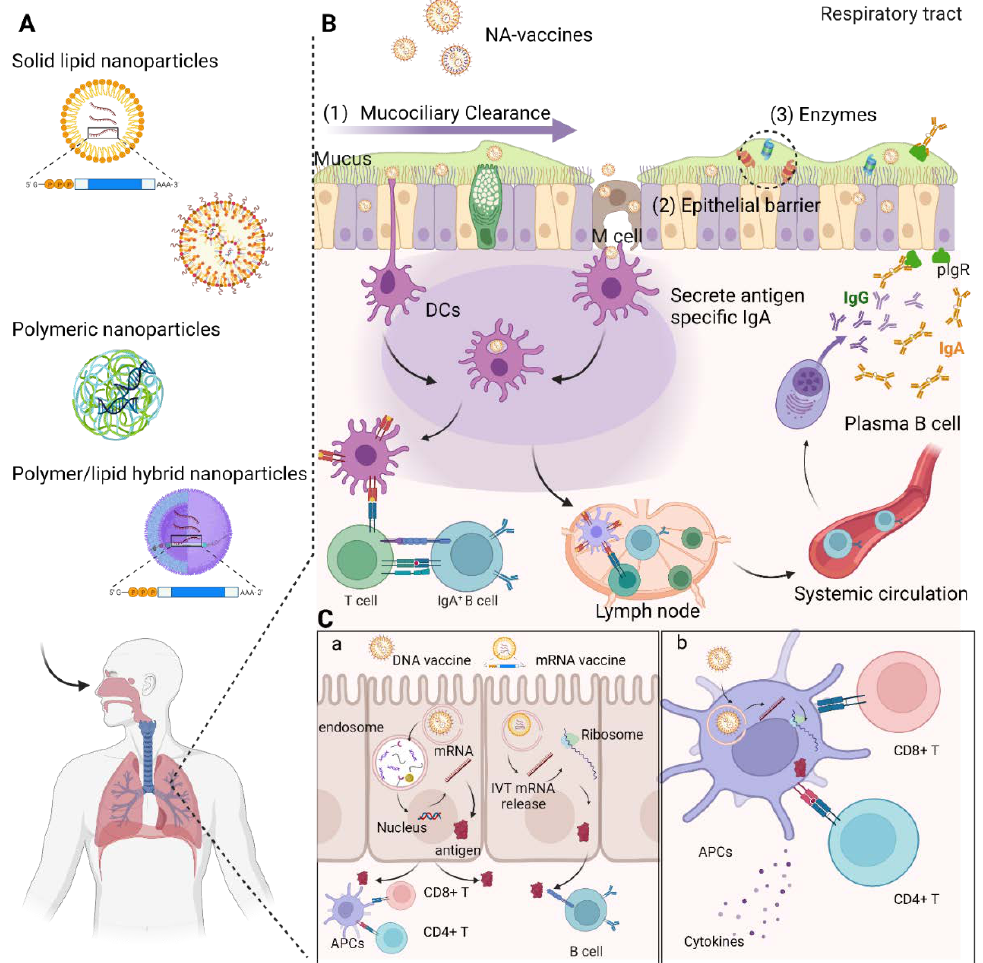
Figure 1. Overview of nucleic acid-based (NA-) vaccines administrated via the respiratory tract using nanotechnologies. ( A ) Schematic view of different nanoparticles used for intranasal and pulmonary vaccinations. ( B ) Physical and biological barriers at the airway mucosal site and mechanism of immune responses in the respiratory tract mediated by mucosal-associated lymphoid tissues (MALTs). NA-vaccines transcytose from the mucus layer into the epithelial tissues by microfold cells (M cells) or passively diffuse through epithelial cell junctions. Other NA-vaccines are captured and internalized by APCs, such as DCs, from their extension through epithelial junctions. APCs that have been transfected with genetic antigens migrate to the nearest lymph node to activate T cells and B cells. Activated B cells proliferate in the lymph node and enter the systemic circulation to the mucosal effector sites. B cells locally differentiate into antibody-secreting plasma cells to produce IgA dimers. IgA dimers are secreted via pIgR at the mucosal surface. Antigen-specific systemic IgG is also produced. ( C ) NA-vaccines are taken up by epithelial cells ( a ), and pathogen-derived antigens are then transcribed and translated from plasmid DNA or IVT mRNA and secreted into the extracellular space, where they can be taken up by professional APCs such as DCs. ( b ). APCs then present antigens to naïve T cells for activation and differentiation, promoting humoral and cell-mediated immune responses against the encoded